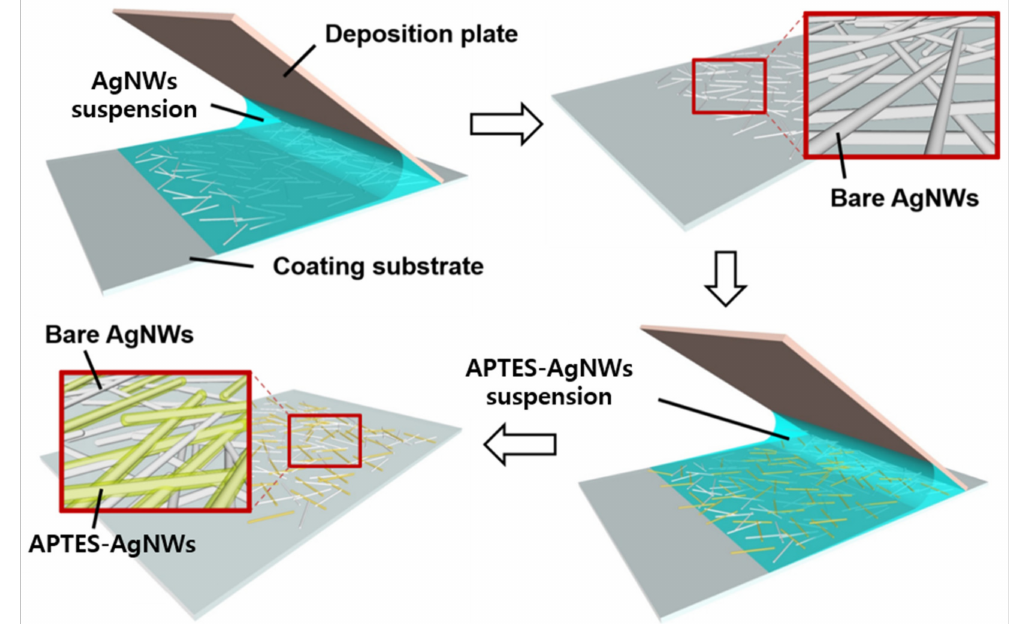
Figure 1. Schematic of the film deposition process using the MDD